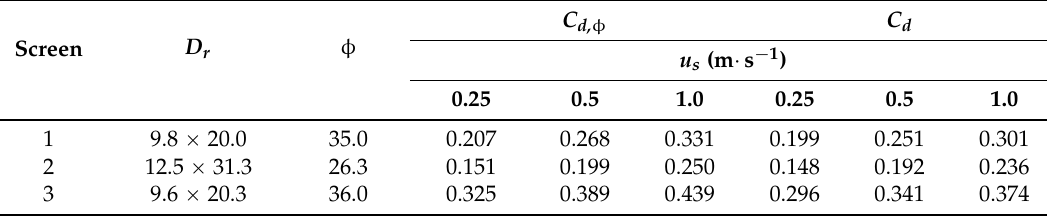
Table 4. Discharge coefficients due to the presence of insect-proof screens C d, φ and of the roof vent C d (for u s of 0.25, 0.5 and 1.0 m·s − 1 ). Insect-proof screen 1 (for sector E of the experimental greenhouse), insect-proof screen 2 (for sector W ) and insect-proof screen 3 (for sector W ). φ , porosity (%); D r ,